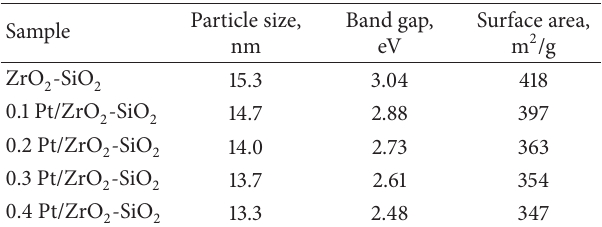
Table 1: The particle size, band gap, and surface area of the prepared catalysts.